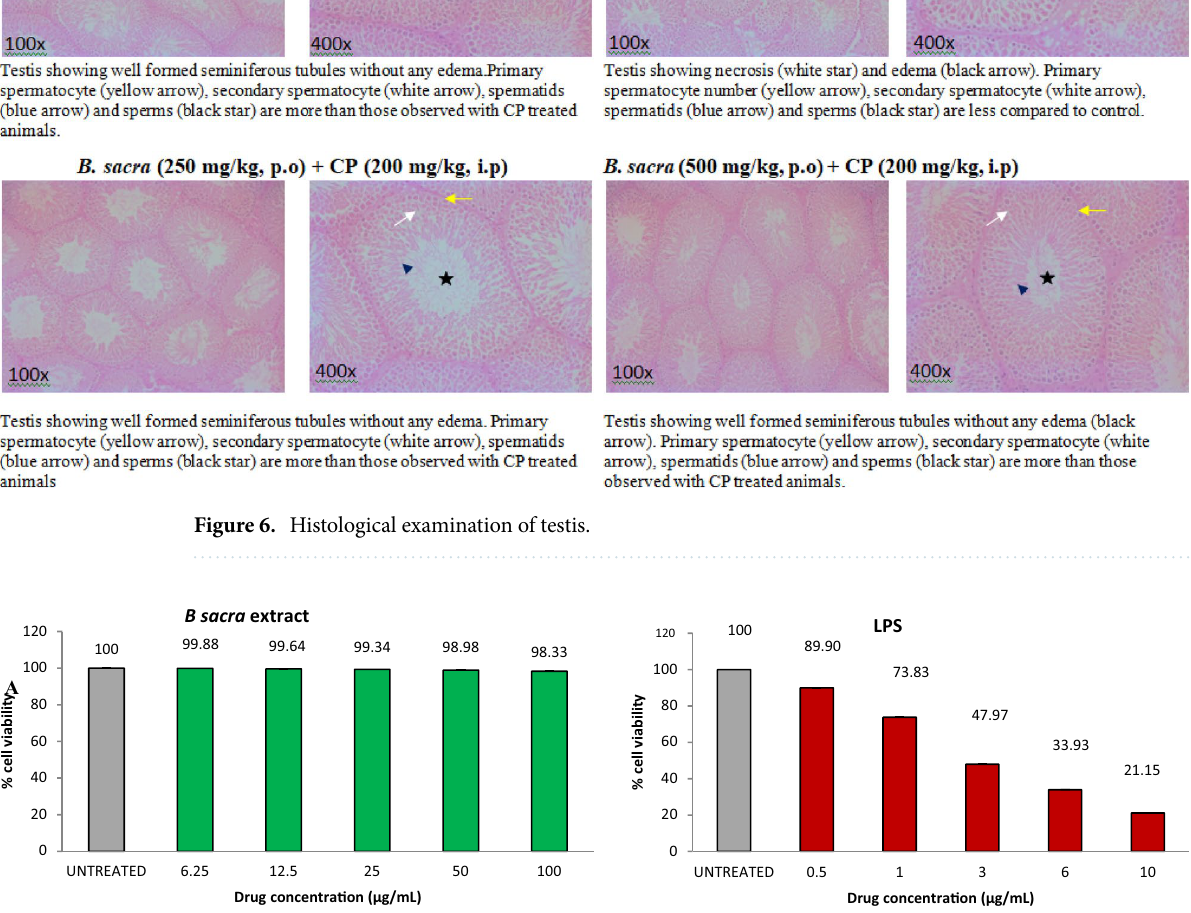
Figure 7. Cell viability assay on human Leydig cells (in-vitro). All values are mean ± SEM, n =